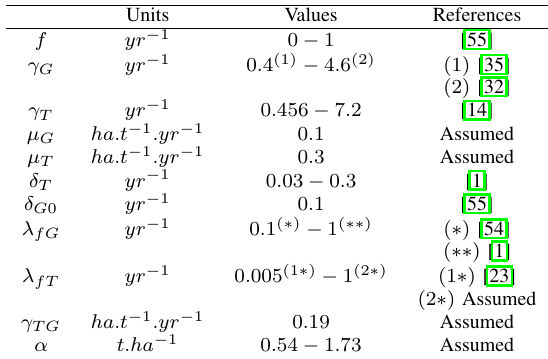
TABLE III: Parameter